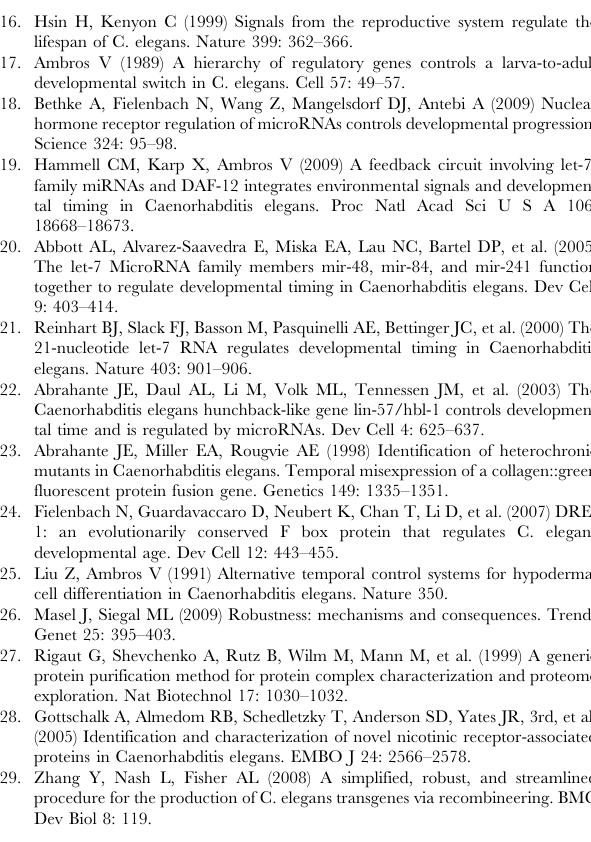
Figure S1 Enriched DAF-12 binding sites were analyzed by (A) DREME or (B) MEME. Figure S2 Comparison between PHA-4 and DAF-12 target genes. Figure S3 DAF-12 binding sites at the lin-42 locus. Figure S4 Heterochronic phenotypes enhanced by daf-12(0) . Figure S5 Mutation of M-2 and DR domains (highlighted) within lin-42A promoter. Mutations are shown above the WT sequence. Figure S6 Heterochronic phenotypes suppressed by dauer formation.